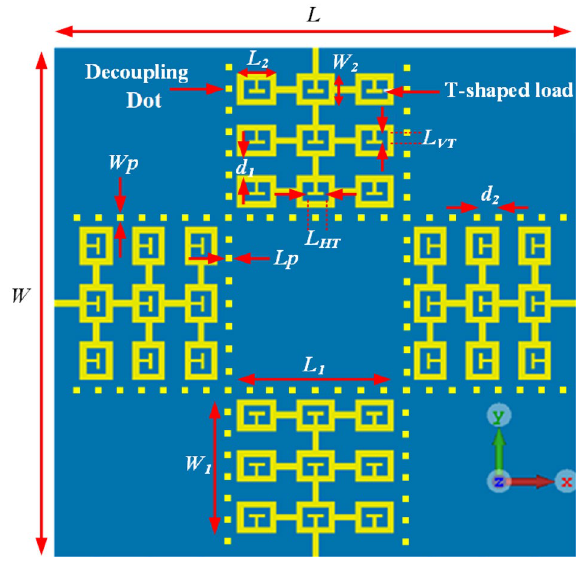
Figure 4. Proposed antenna array loaded with T-shaped matching stubs and decoupling dot-walls. The magnitude of the annotated geometrical parameters is listed in Table 1.